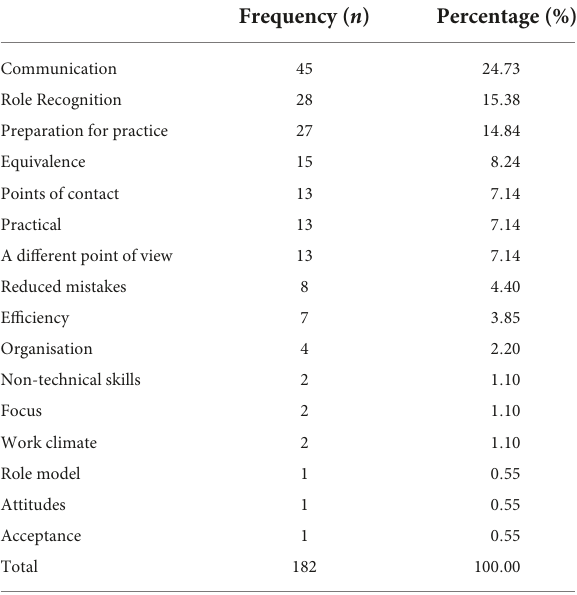
TABLE 3 Citation frequency and text coverage of further